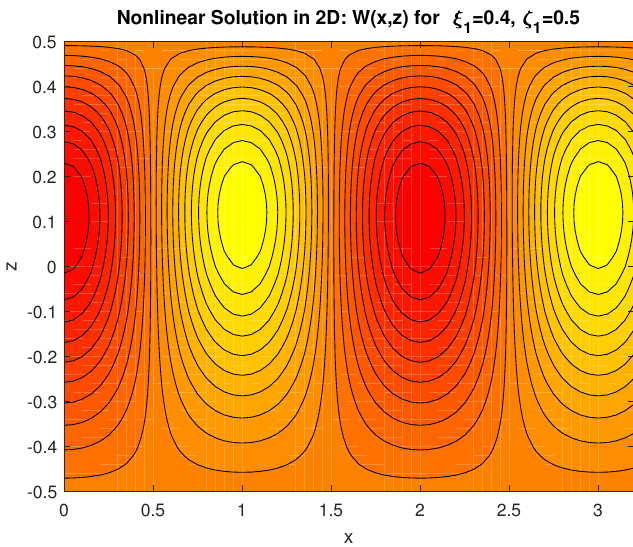
Figure 16. Nonlinear 2D solution for W , i.e., (cid:101) ( W 10 ( x , z ) + δ W 11 ( x , z ) + (cid:101) W 20 ( x , z ))